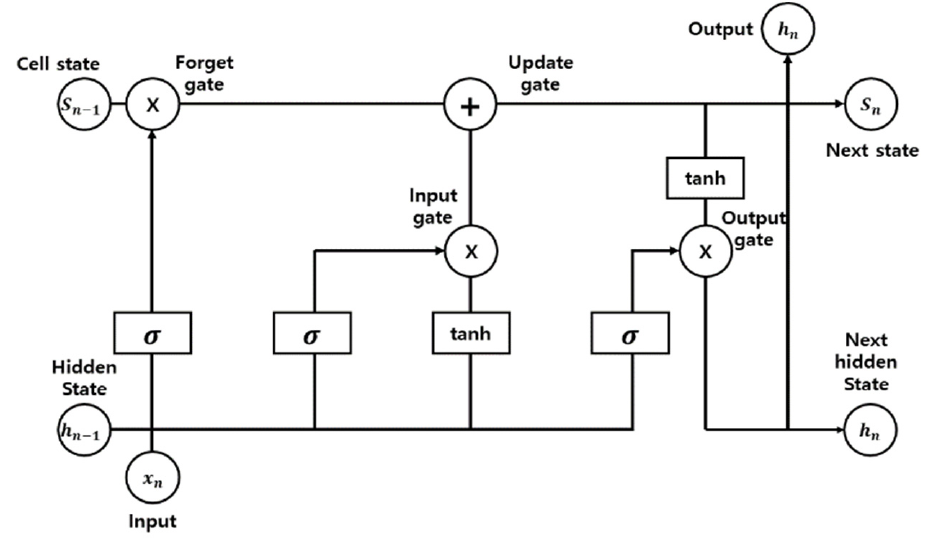
Figure 7. Structure of an LSTM.